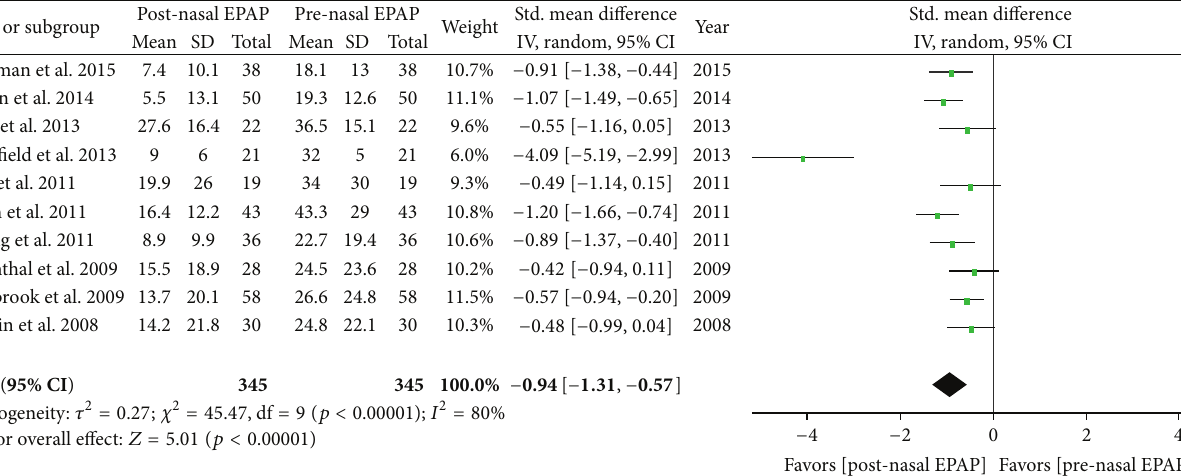
Figure 3: Pre- and post-nasal EPAP therapy outcomes for apnea-hypopnea index (events per hour), standardized mean difference. SD: standard deviation; CI: confidence interval; nasal EPAP device: nasal expiratory positive airway pressure device (Provent).